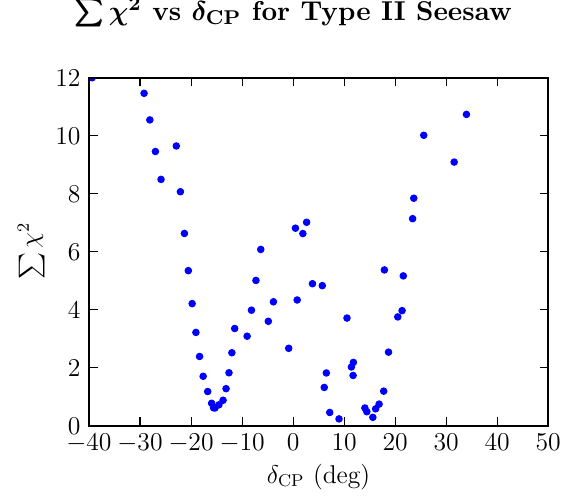
Figure 5 . Comparisons of the Dirac CP phase angle to sum of chi squares for the model in the type-II seesaw case.